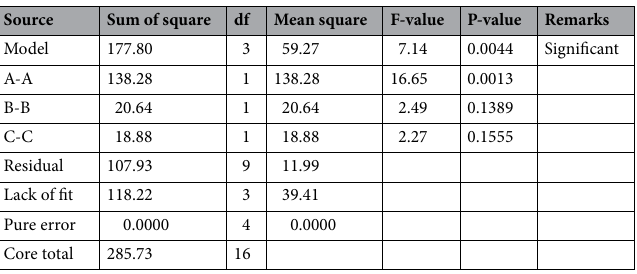
Table 4. Analysis of variance (ANOVA) for the biodiesel production from waste corn oil over SSE@ GO-CuFe